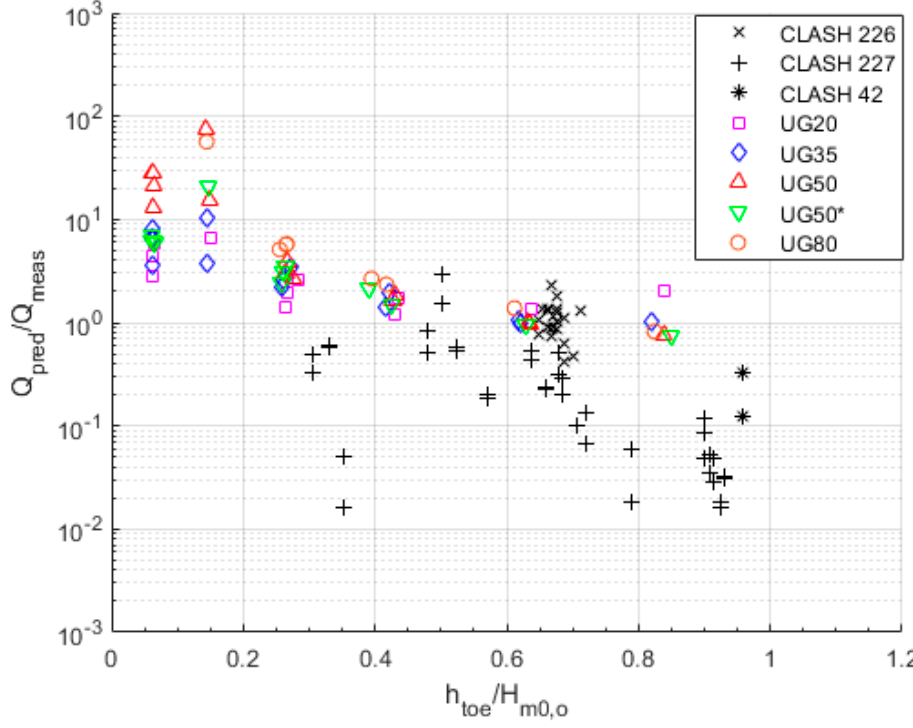
Figure 14. Ratio of dimensionless predicted by Lashley et al. [7] to measured overtopping discharge versus the relative water depth.